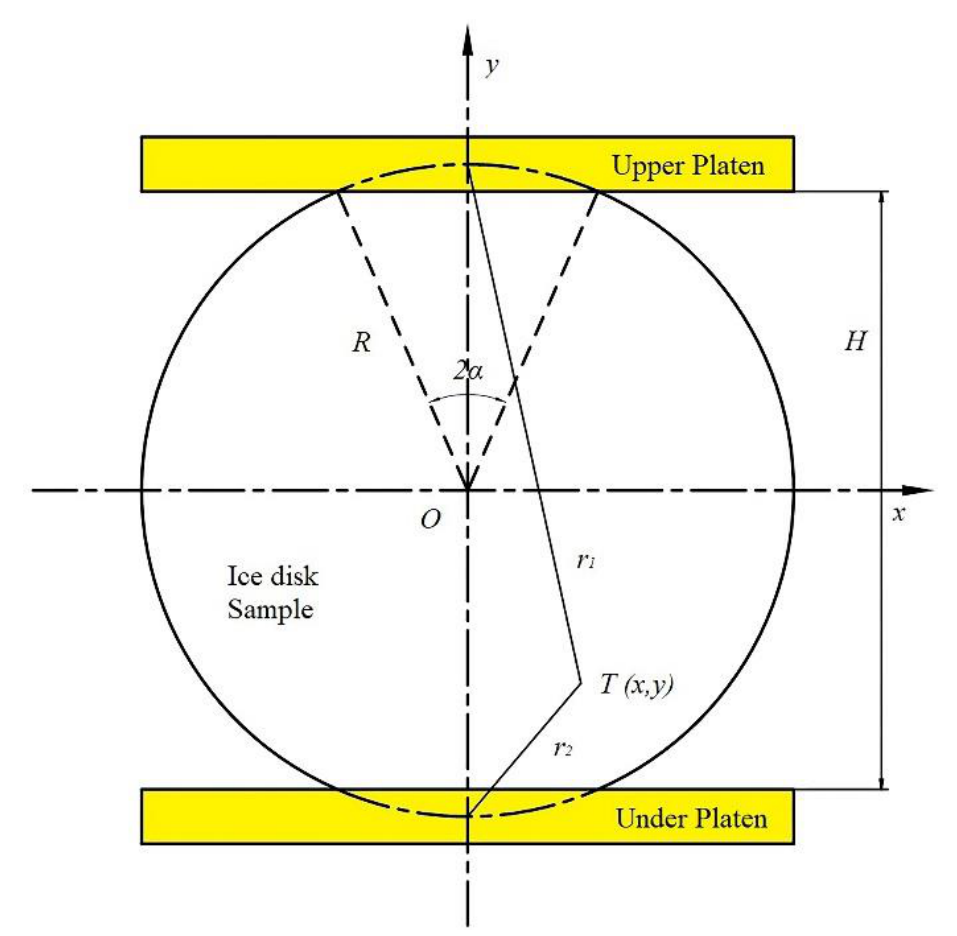
Figure 14. The condition of the ice with platform.